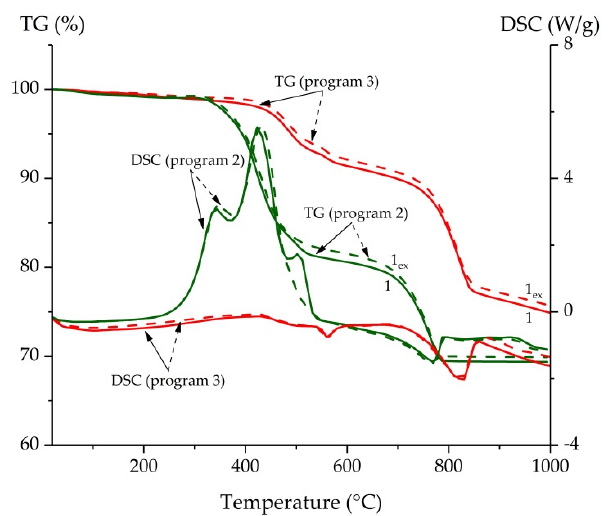
Figure A2. TG and DSC curves for rock samples. Green curves are for oxidizing atmosphere (program 2); red curves for inert gas measurement (program 3). Samples: before (1)—solid line; after (1 ex ) bitumen extraction—dashed.